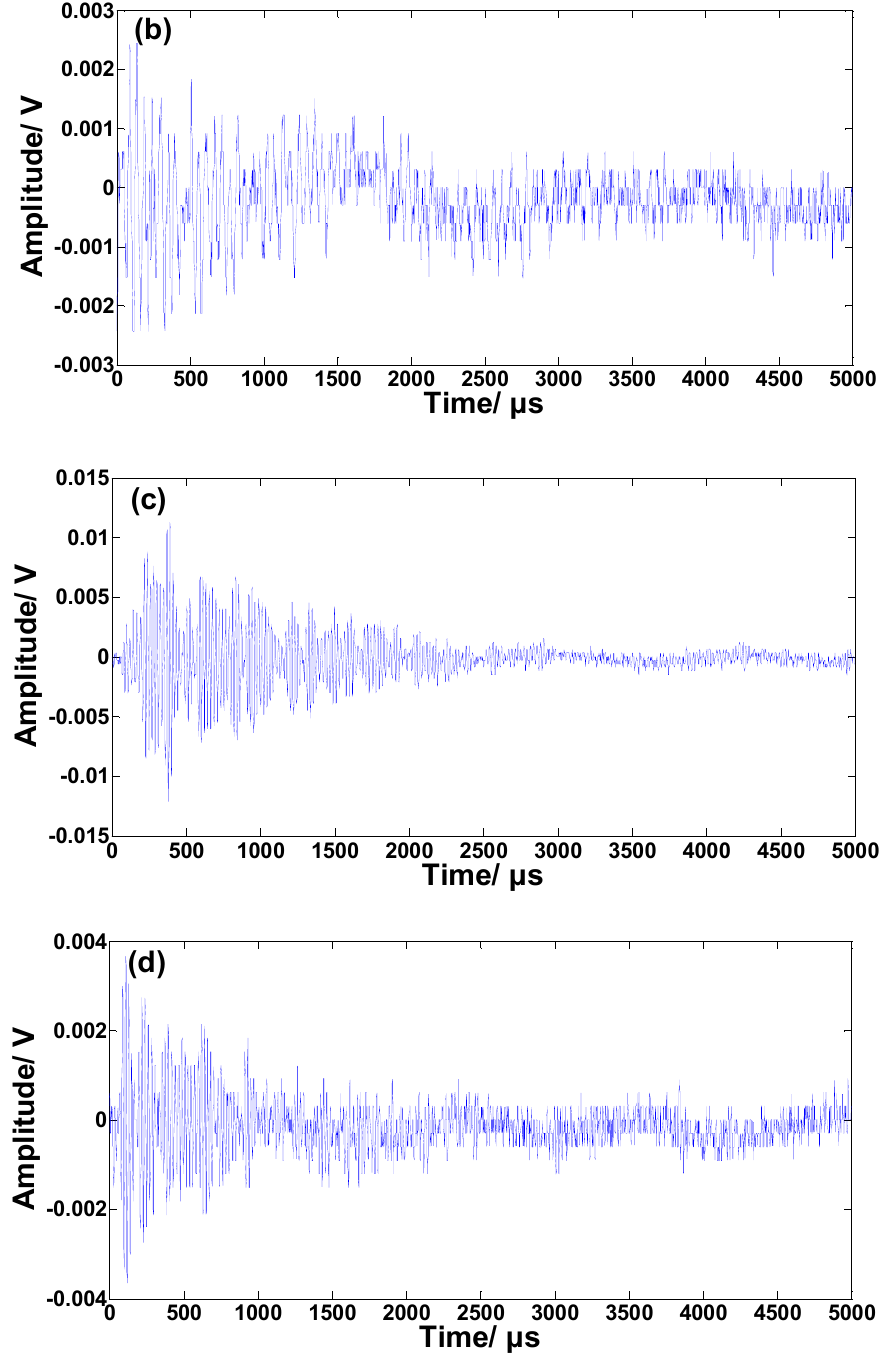
Figure 10. Waveforms from top to bottom: ( a ) and ( b ) low duration with low frequency and low counts, ( c ) high duration with low frequency and low counts, ( d ) high duration with high frequency and high counts.